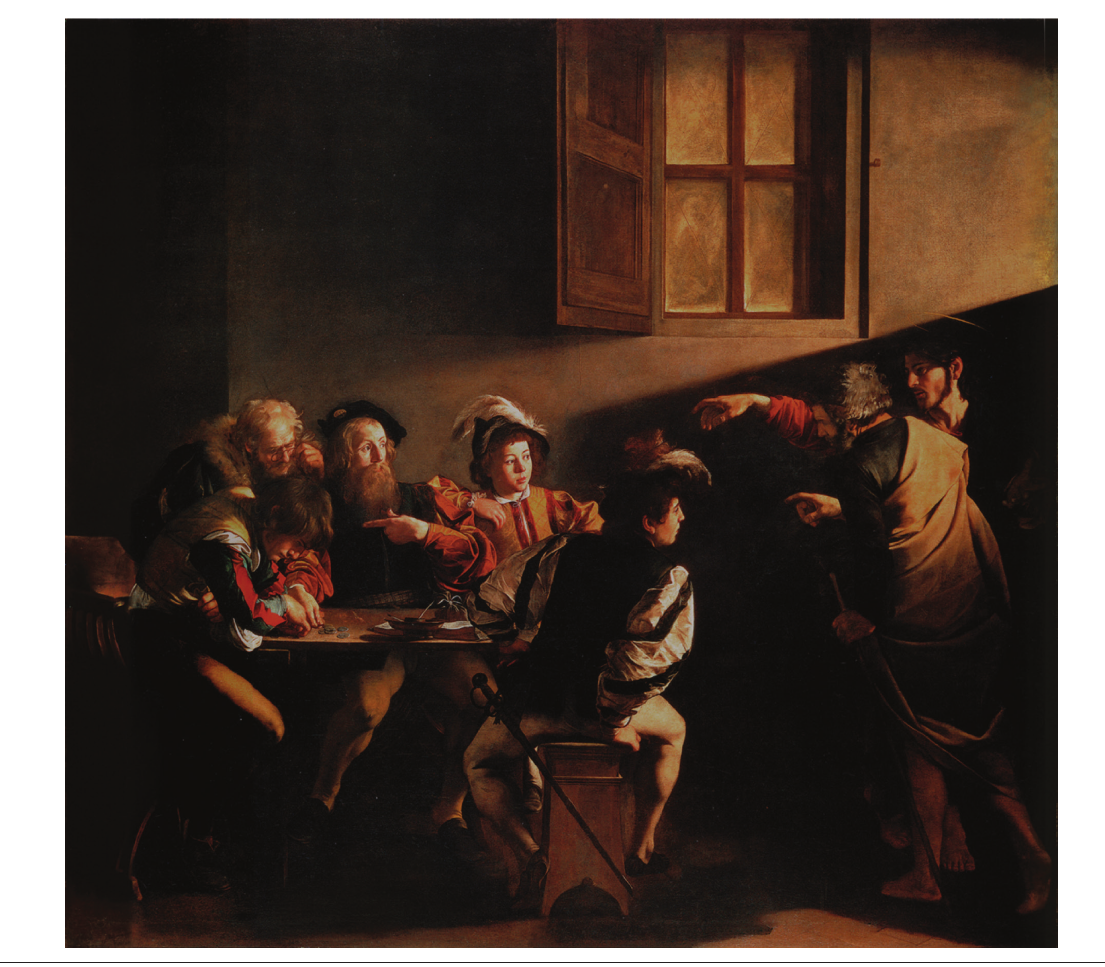
Figure 5. The Calling of Saint Matthew , Caravaggio (1599–1600; Source: San Luigi dei Francesi,